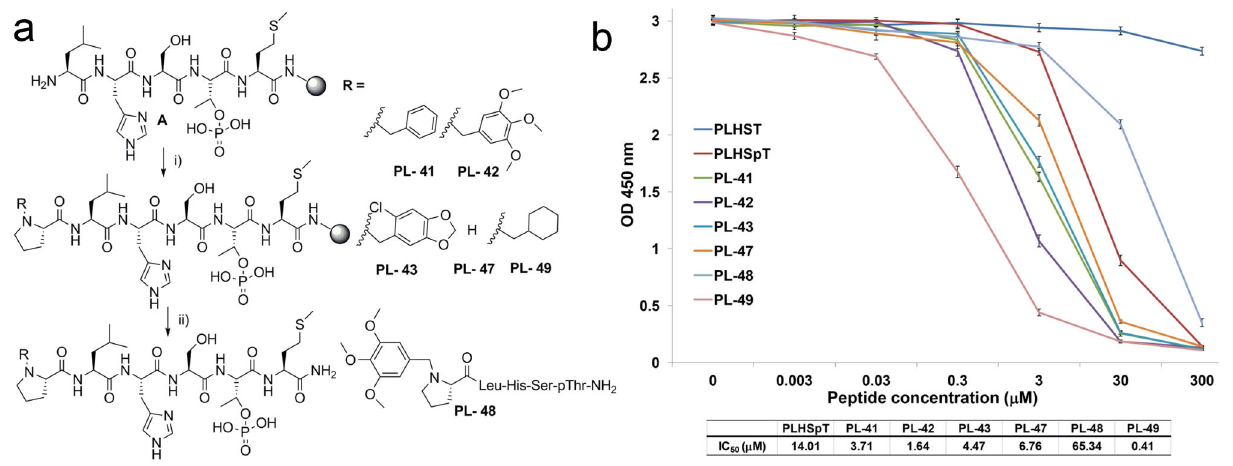
Figure 2. First-phase diversification of peptides, and quantification of their inhibitory activities against Plk1 PBD. (A) First- phase N- terminal-truncated PLHSpT derivatives generated using solid-phase peptide synthesis (SPPS). i) RCH HOBt, DIPEA, DMF, 4 h; ii) TFA/TIS/H O (90:5:5), 2.5 h; (b) ELISA-based Plk1 PBD-binding assay result using first-phase N- 2 terminal-truncated peptide derivatives. Representative graphs from three independent experiments are shown (O.D., optical density).